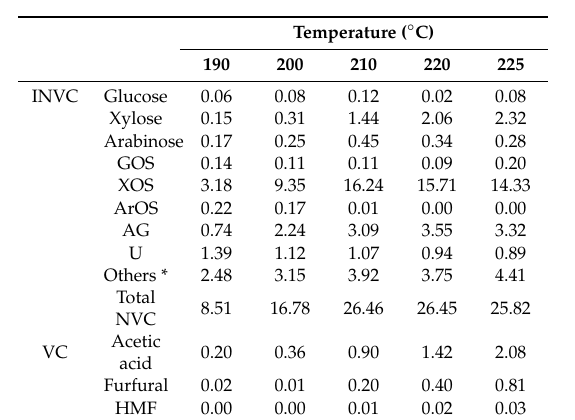
Table 3. Concentrations of products present in the liquid phase of hydrothermal treatments performed at temperatures ranging from 190 to 225 ◦ C. Data are expressed in g /